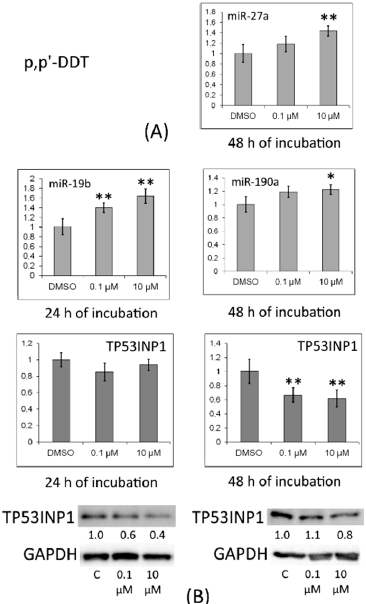
Figure 5. ( A ) Relative levels of TP53INP1 mRNA and of miRNAs targeting it (miR-19b, miR-27a, and miR-190a) in MCF-7 cells exposed to p,p ′ -DDT. The Y-axis indicates the ratio of the mRNA or miRNA amount in the cells treated with a DDT isomer to the mRNA or miRNA amount in the cells treated with DMSO. Each value is the mean of three independent experiments. * Significant differences from the control ( p < 0.05); ** p < 0.01. ( B ) Western blot analysis of TP53INP1 in cells incubated with p,p ′ -DDT. The numbers under TP53INP1 bands represent fold change in the protein level as compared to the first band (control); each data point was normalized to the corresponding GAPDH band. We present data from one of three independent experiments (which yielded similar results). In cells treated with o,p ′ -DDT for 24 h, this protein’s level declined too (Figure 6).